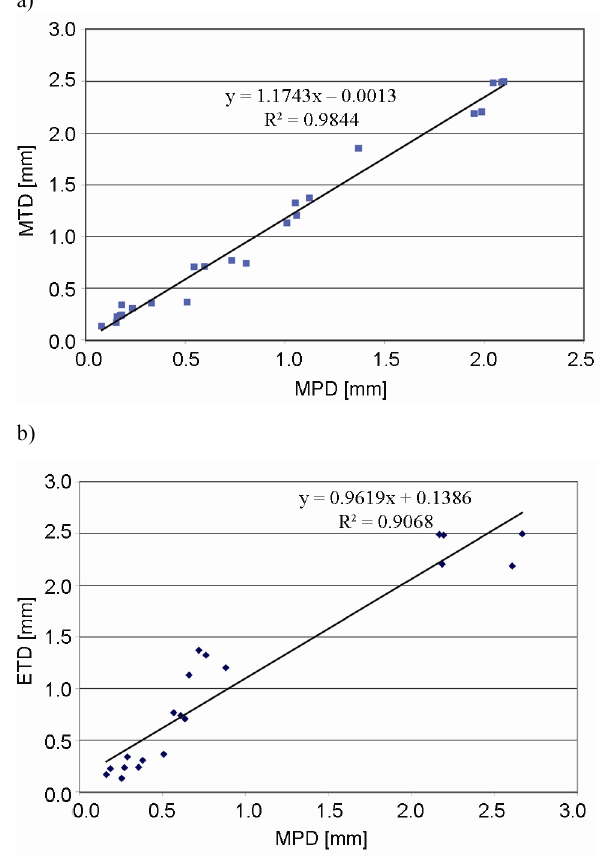
Fig. 7. Linear relationship between MTD from sand patch test and: a) laser scanner; and b) laser profiler Table 2. Summary of proposed macrotexture relations and ASTM standard equations (in mm units) Method ASTM Standards Proposed